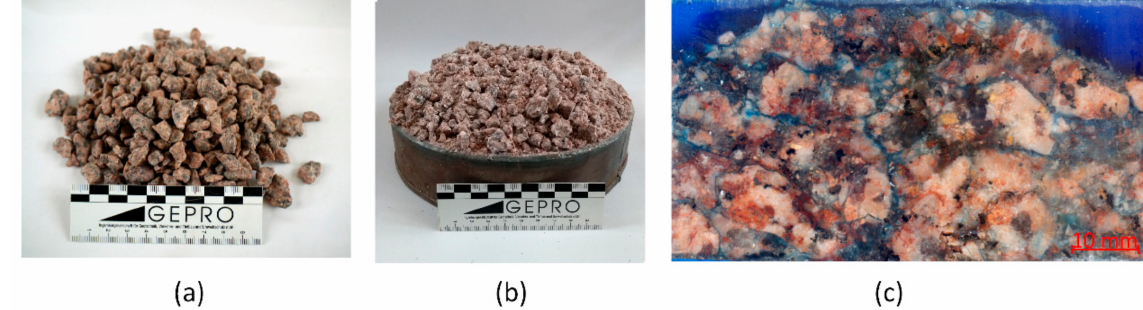
Figure 4. Material from the real particle bed test: ( a ) Raw granite particles of size range 8 to 12.5 mm; ( b ) Product directly after the particle bed test with 20 MPa just before further preparation; ( c ) Section through the center of the fixed specimen of the prepared particle bed.